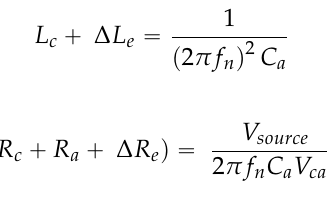
Figure 5. Magnetic flux density at the surface of the coil and the steel bar.